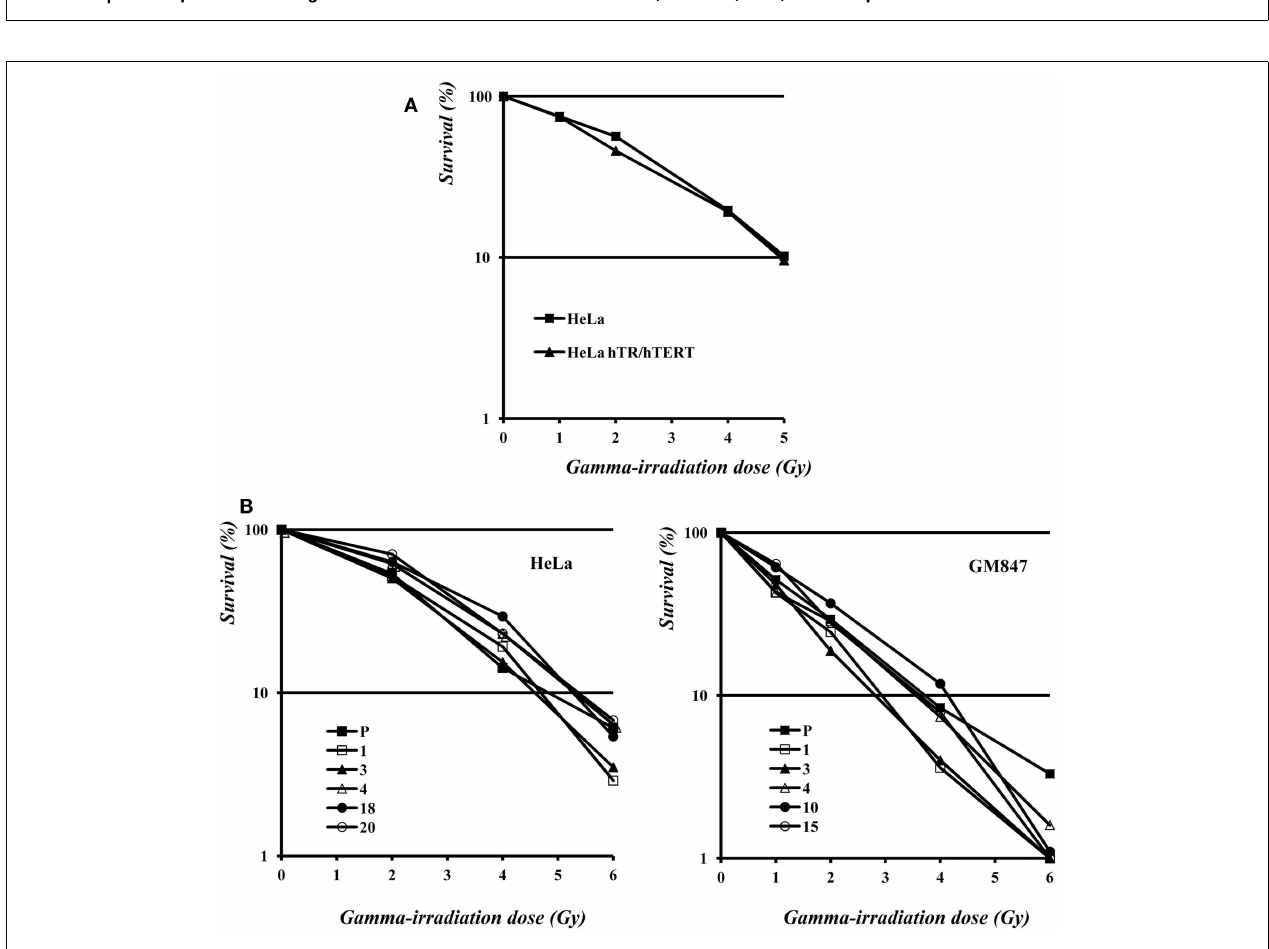
suggesting that, in ALT cells as well as in telomerase positive cells, TERRA expression does not influence radiation sensitivity. How- ever, GM847 cells are more sensitive to irradiation (10% survival between 2 and 4 Gy) than HeLa cells (10% survival at 5 Gy); this relative hypersensitivity may be related to the ALT